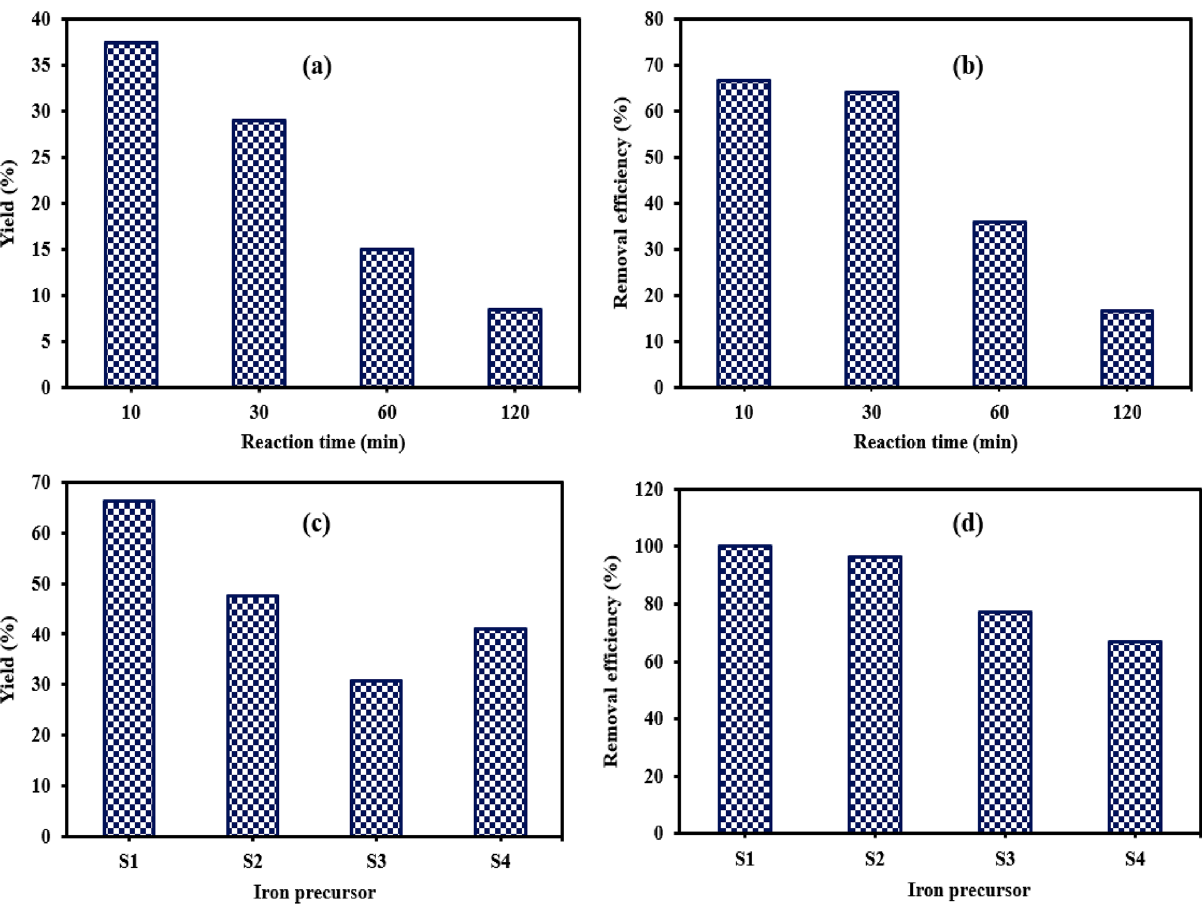
Figure 1. Effect of reaction time on ( a ) NZVI yield (%) and ( b ) removal efficiency of acid blue-25 (%) and Effect of iron salt on ( c ) NZVI yield (%) and ( d ) removal efficiency of acid blue-25 (%). (S1: FeCl 2 .4H 2 O, S2: FeCl 2 , S3: FeCl 3 .6 H 2 O, S4: FeSO 4 .7H 2 O, dye concentration = 50 mg L -1 , NZVI dose = 0.1 g, solution volume = 100 mL, agitating time = 60 min, agitation rate = 200